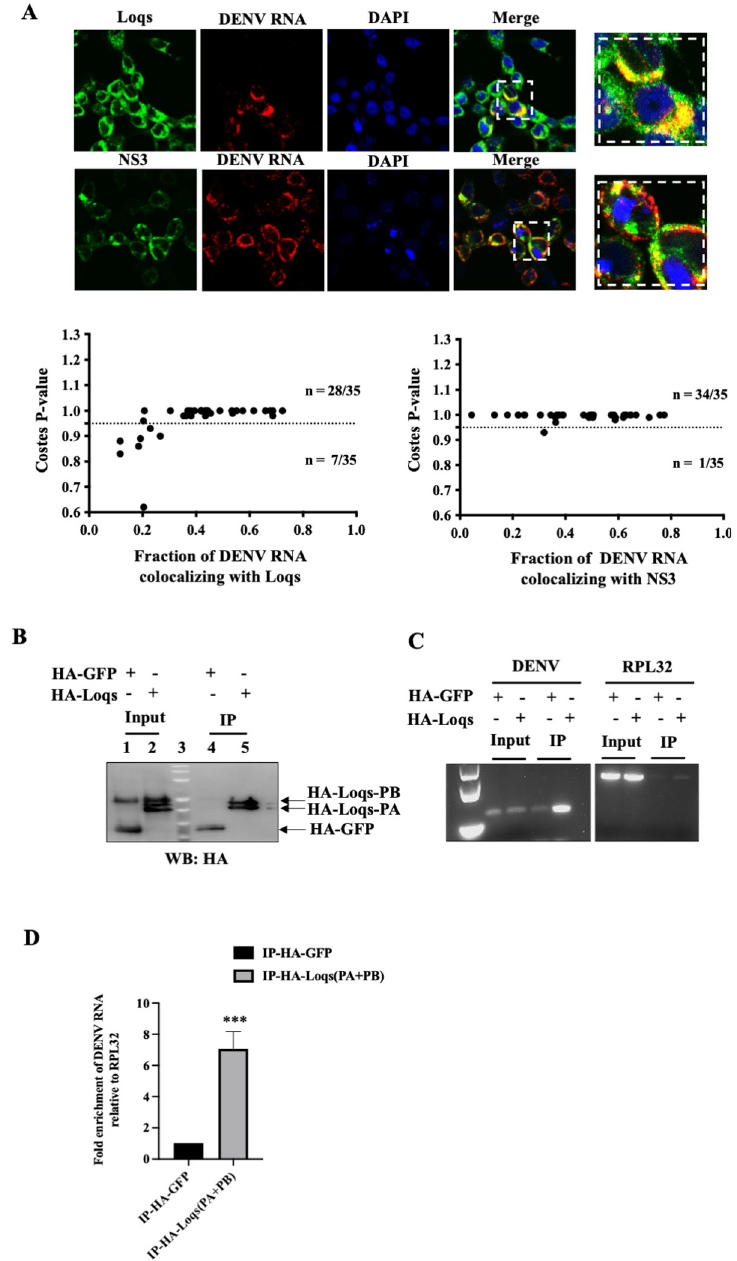
Fig 4. Colocalization and interaction of Loqs protein with DENV RNA. (A) Fluorescent in situ hybridization imaging of Aag2 cells infected with DENV2 at an MOI of 1 after 48 hrs. NS3 and Loqs proteins (shown in green) were visualized using labeled antibodies, while DENV RNA (shown in red) was visualized using labeled antisense RNA probes. Costes p value was calculated to measure the extent of colocalization of DENV2 RNA with NS3/Loqs proteins. (B) Immunoprecipitation of HA-tagged Loqs from Aag2 cells infected with DENV2 at a MOI of 1. Aag2 cells transfected with HA-GFP or HA-Loqs PA/PB plasmids were infected with DENV2 for 48 hrs, and immunoprecipitations were performed with anti-HA antibodies. Abundances of HA-GFP and HA-Loqs in input lysates and immunoprecipitated material measured by western blot analysis. (C) DENV2 and RPL32 RNA abundances in immunoprecipitated RNA (IP) and input RNA (10%) were measured by semi-quantitative RT-PCR. A representative agarose gel image from three independent experiments is shown. (D) DENV2 RNA abundance in immunoprecipitated RNA (IP) as measured by RT-qPCR. Data was normalized to RPL32 mRNA levels (n = 3, ��� p = 0.0006).